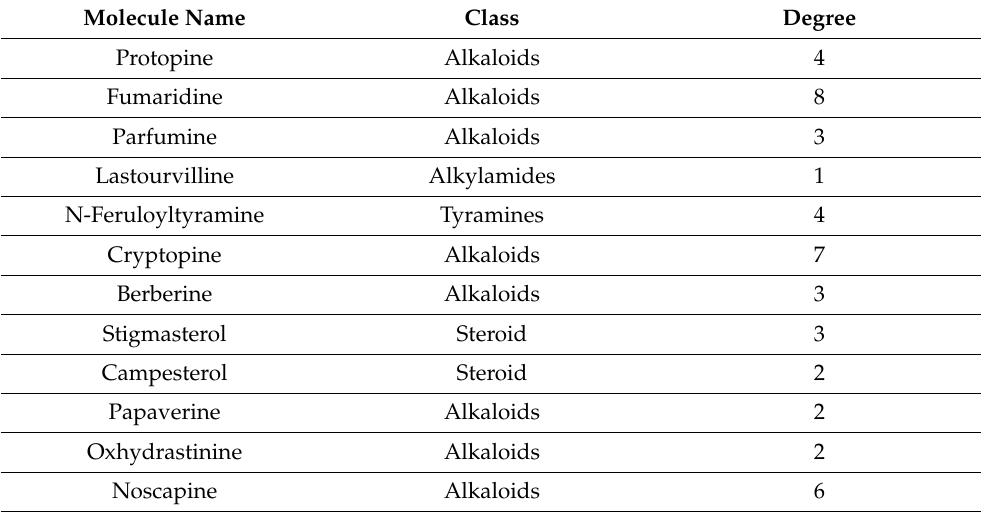
Table 2. Degree of 12 compounds explored through network analyzer in